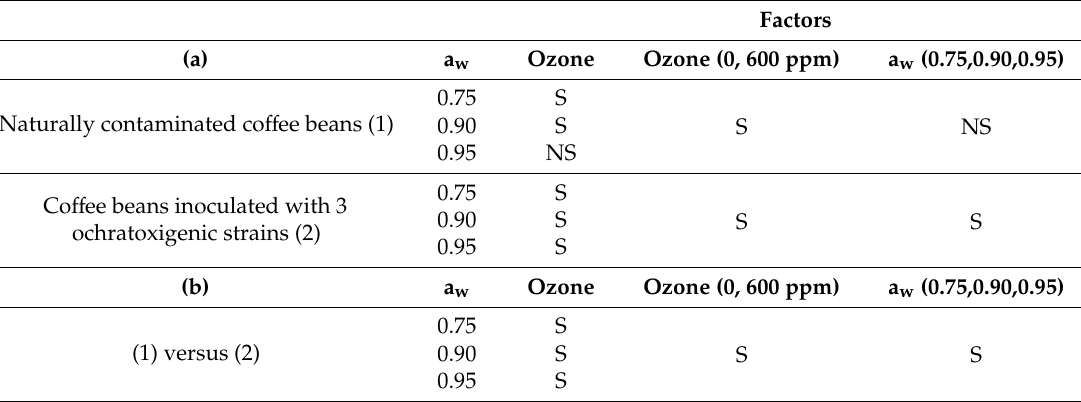
Table 4. The statistical analysis of the e ff ect of O 3 treatment on ochratoxin A (ng g − 1 ) production in (a) naturally contaminated co ff ee beans and that inoculated with conidia of 3 toxigenic species when compared with the untreated controls and (b) comparison with control of OTA production in naurally contaminated and that inoculated with a mixture of the three species in relation to O 3 and a w × O 3 using ANOVA